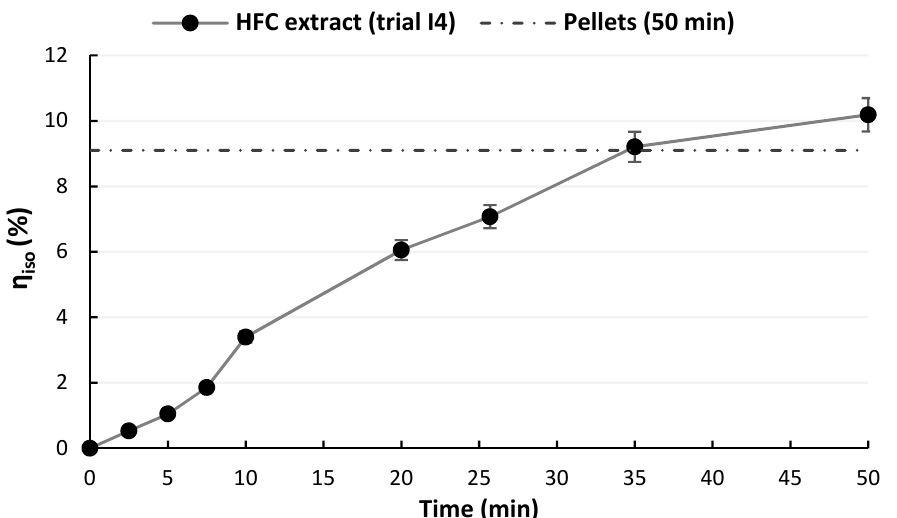
Figure 7. Isomerization yield ( η iso ) evaluated during 50 min boiling at pilot scale (trial I4). Horizontal line indicates the isomerization percentage reached after 50 min boiling by pellet addition.